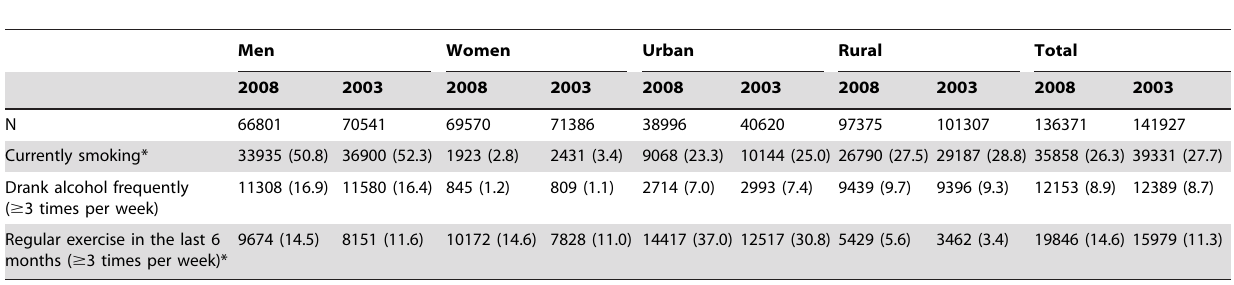
Table 3. Prevalence of smoking, alcohol intake, and physical activity in respondents aged . 18 years in